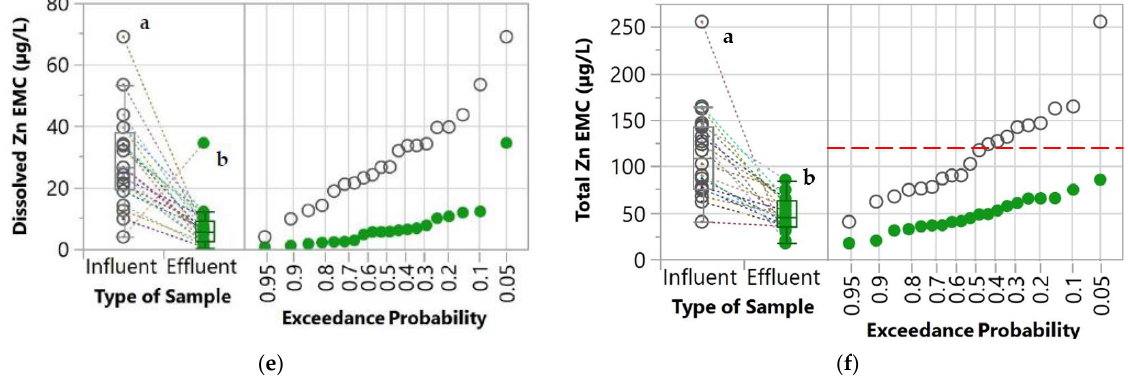
Figure 4. Box plot and normal probability plot of ( a ) dissolved Cu, ( b ) total Cu, ( c ) dissolved Pb, ( d ) total Pb, ( e ) dissolved Zn, and ( f ) total Zn EMCs of both influent and effluent samples. A pair of influent and effluent EMCs from the same storm event and catch basin are connected with dotted lines. Different lowercase letters (a and b) indicate significant differences between influent and effluent ( p < 0.05). The red horizontal dashed line represents water quality goals [34]. Note: The water quality goal for Pb (65 µg/L) is not shown since it is greater than the upper limit of the y -axis.